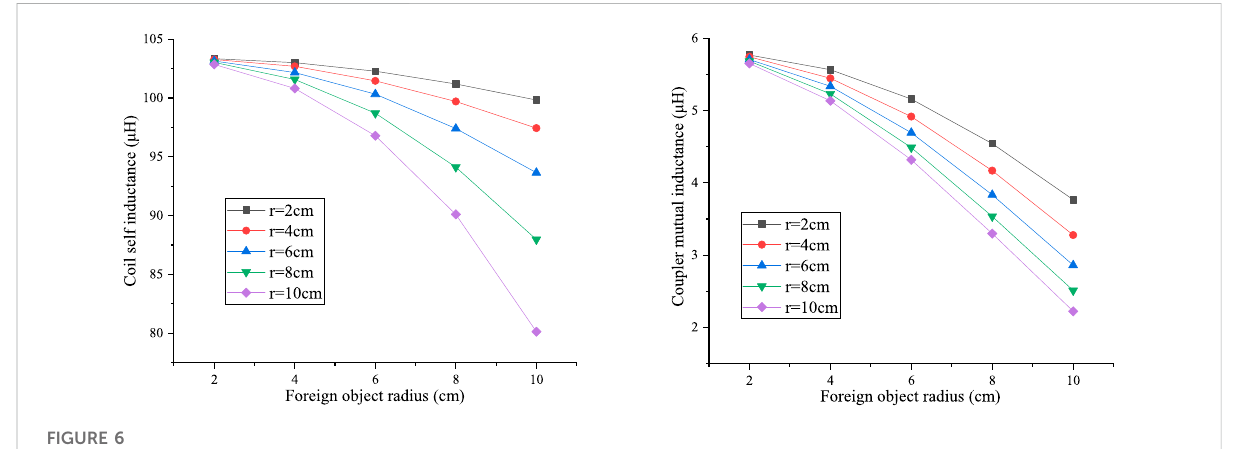
FIGURE 6 In fl uence of the changes in foreign object radius on coupler